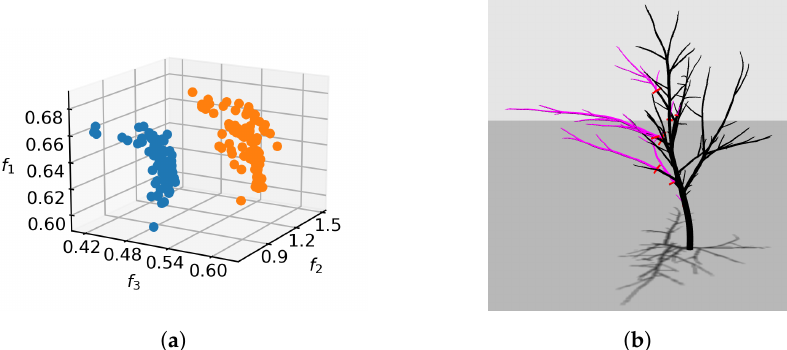
Figure 11. The effect of relaxing constraint f 4 on SPEA2 optimization for the tree from Figure 6a: ( a ) The SPEA2 non-dominated sets obtained with tight (blue) and loose (orange) bound. ( b ) An example of excessive pruning that overfits on the balance objective.